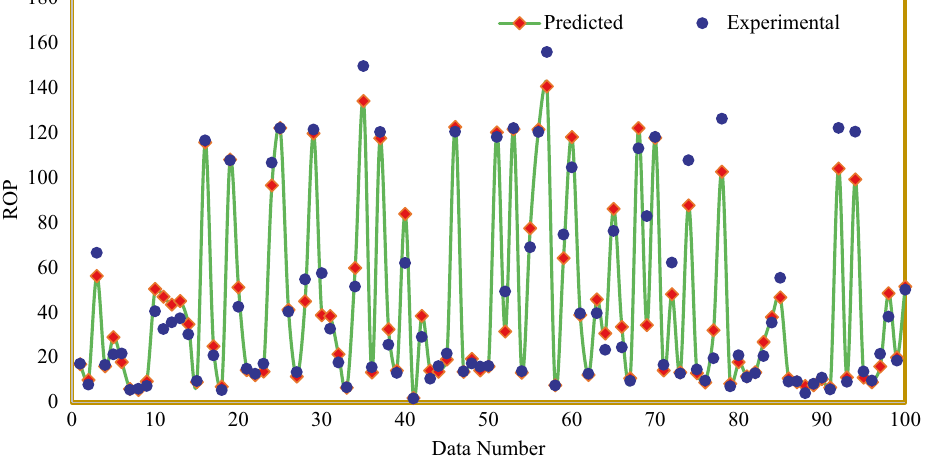
Figure 11. Comparison of experimental data and output of DT-GB model for the first 100 testing data points.